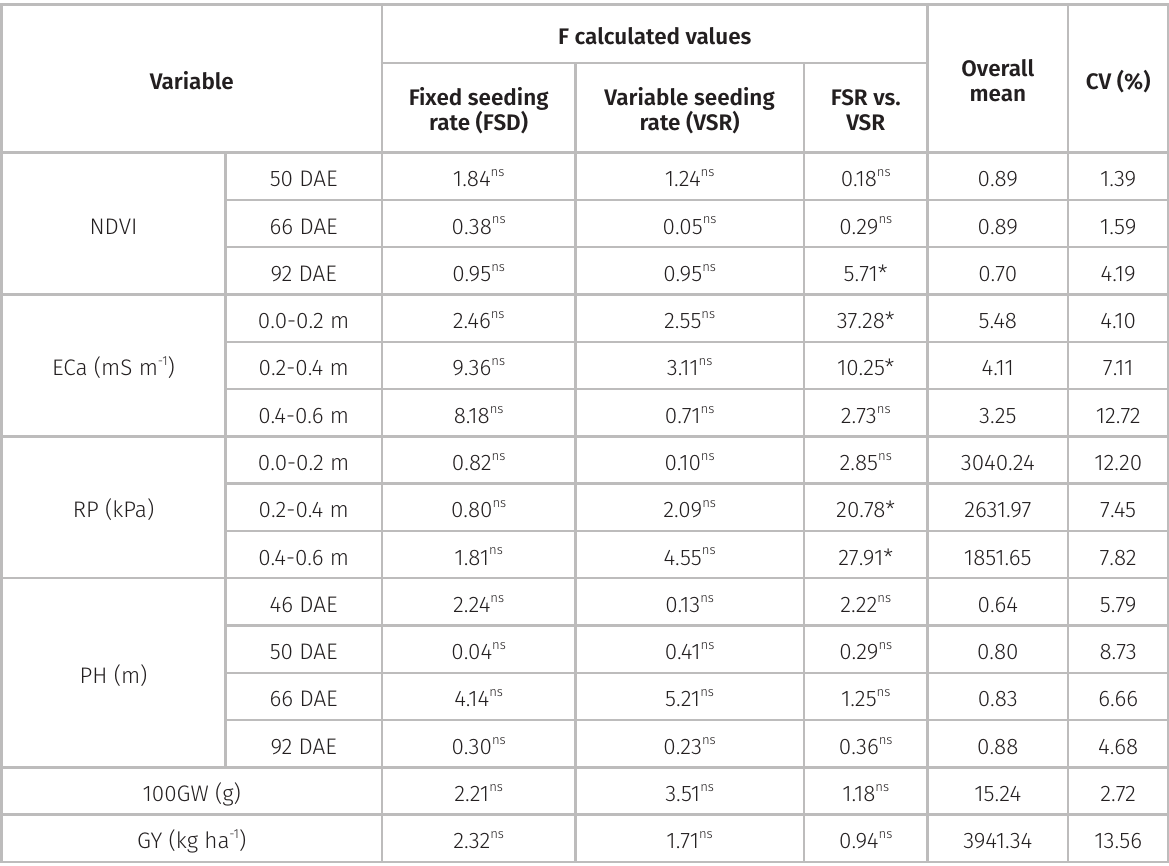
Table III. F calculated values for NDVI, soil apparent electrical conductivity (ECa) and soil mechanical resistance to penetration (RP) evaluated at different depths (m), plant height (PH) evaluated at different days after emergence (DAE), 100-grain weight (100GW), and grain yield (GY) evaluated at different days after emergence of soybean cultivated under variable seeding rate and fixed seeding